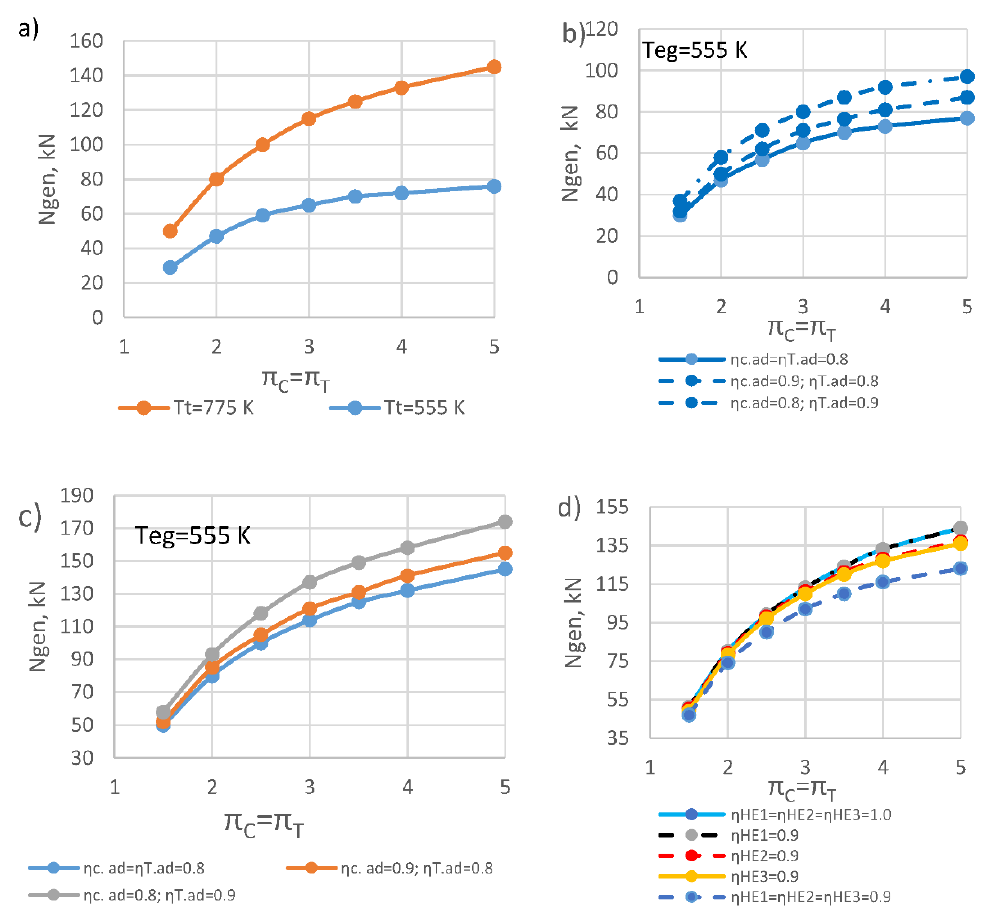
Figure 5. E ff ect of technological system parameter π C = π T on N gen . ( a ) for internal combustion engine Figure 5. Effect of technological system parameter π C =π T on 𝑁 𝑔𝑒𝑛. ( a ) for internal combustion engine exhaust gas temperature: 1: T g = 775 K, 2: T g = 555 K. ( b ) For turbo unit e ffi ciency: 1: η k.ad = η T.ad = exhaust gas temperature: 1: T g =775 K, 2: T g =555 K. ( b ) For turbo unit efficiency: 1: η k.ad = η T.ad = 0.8; 2: η k.ad = 0.9, η T.ad = 0.8; 3: η k.ad = 0.8, η T.ad = 0.9. ( c ) For turbo unit efficiency: 1: η k.ad = η T.ad = 0.8; 2: η k.ad = 0.9,